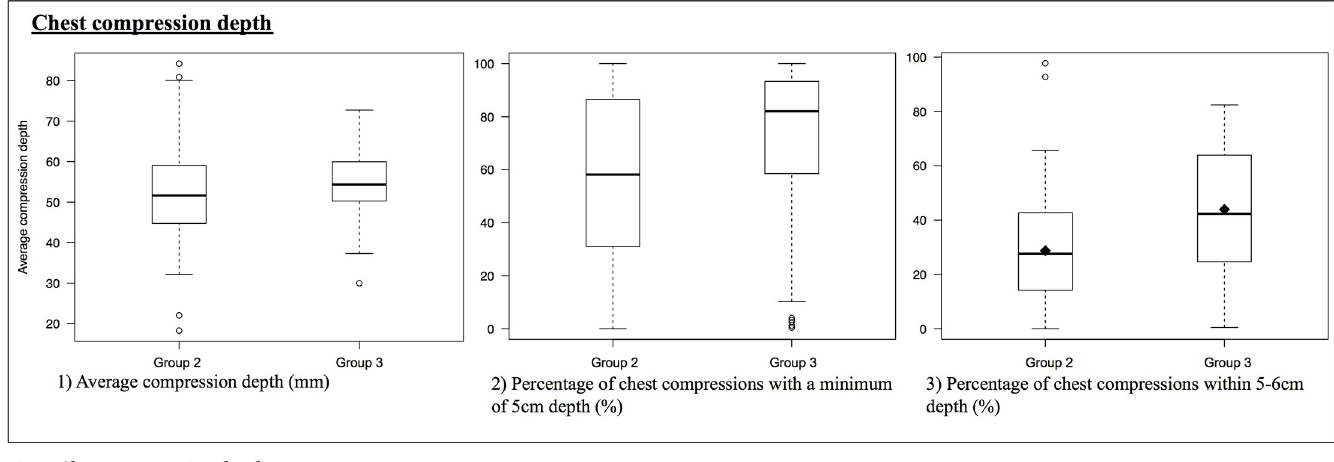
Fig 5. Chest compression